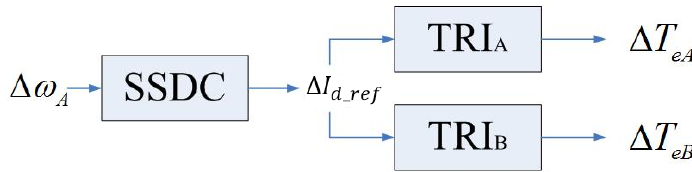
Figure 3. Phase relationship of key variables concerned in double-generator SSDC